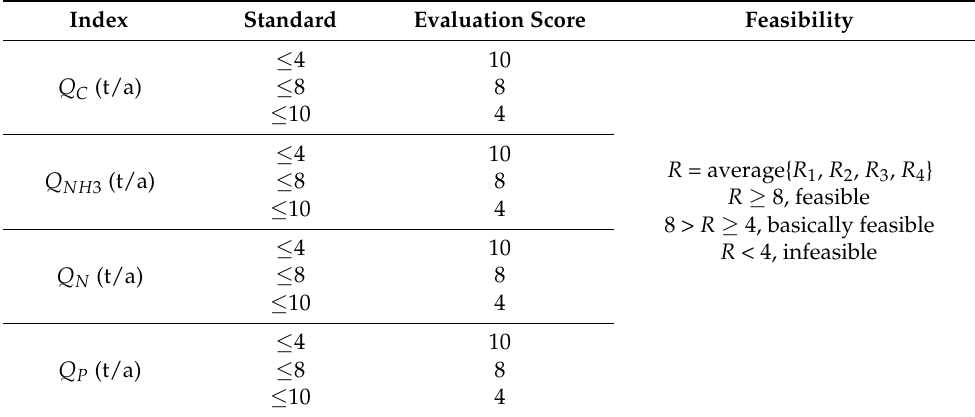
Table 3. Feasibility assessment system based on marine